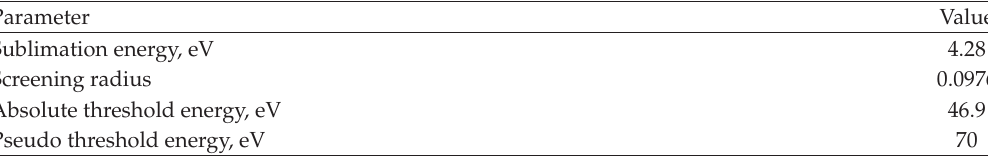
Table 3: Sputtering